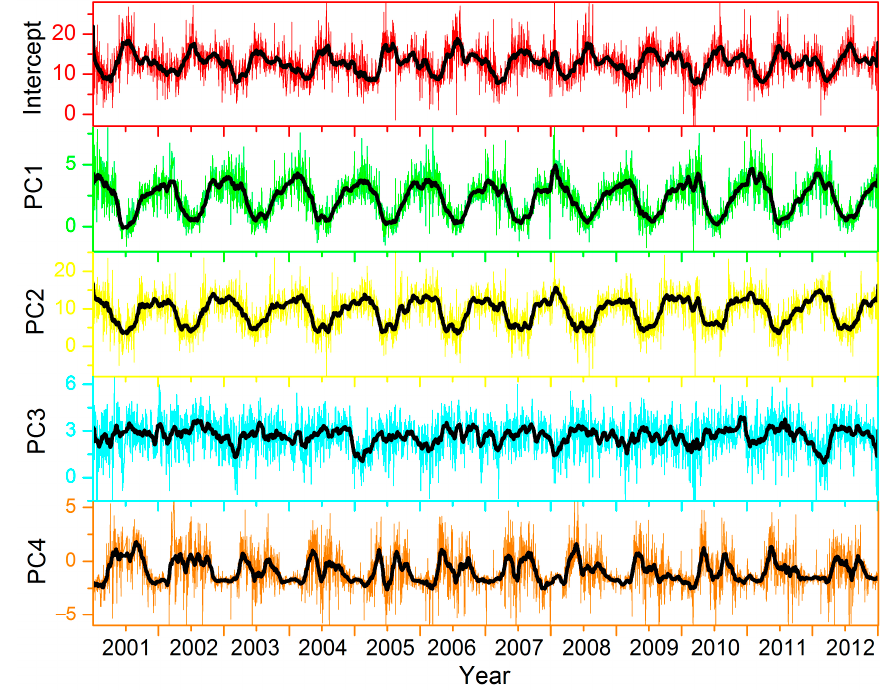
Figure 6. Coefficients and intercept of the linear regression day by day between Ta and PC1–PC4. The thin lines are the daily results and the thick lines are the smoothed results by a 30-day moving window.